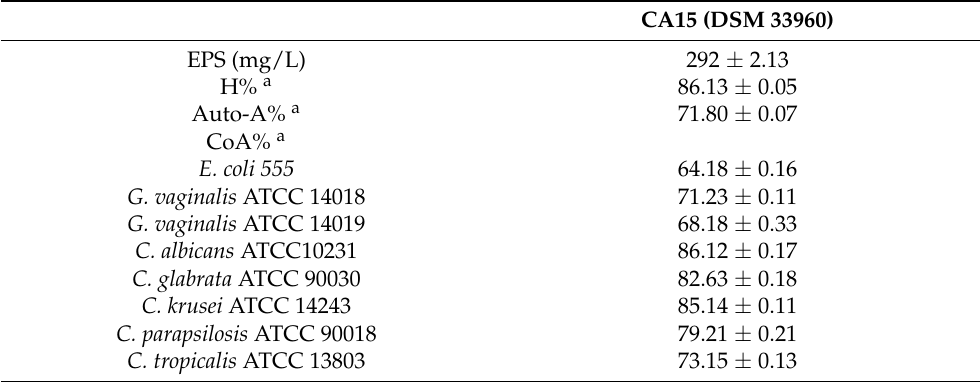
Table 8. Exopolysaccharide (EPS) production, hydrophobicity, autoaggregation, and coaggregation abilities exhibited by the L. rhamnosus CA15 (DSM 33960)